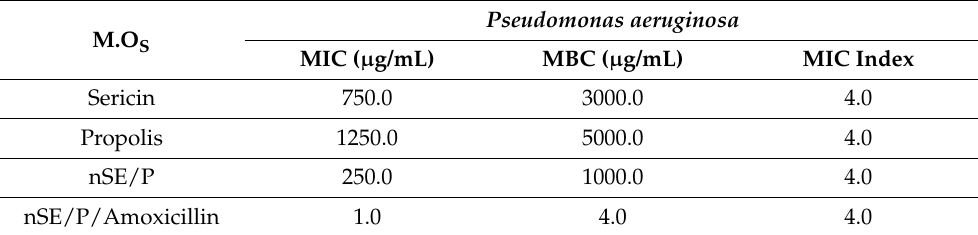
Table 6. MIC, MBC and MIC index evaluation of the most promising nanoformula against P. aeru- ginosa.